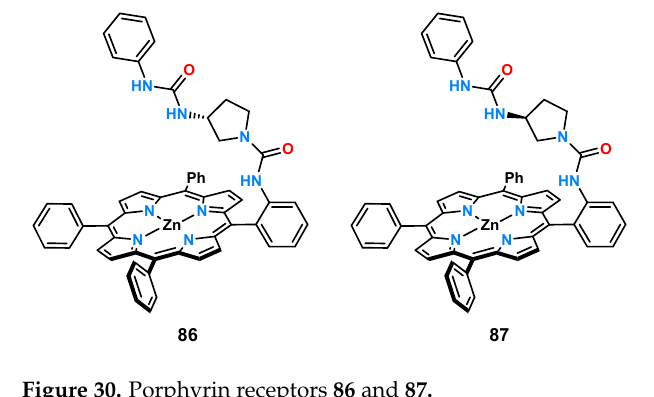
Figure 30. Porphyrin receptors 86 and 87.